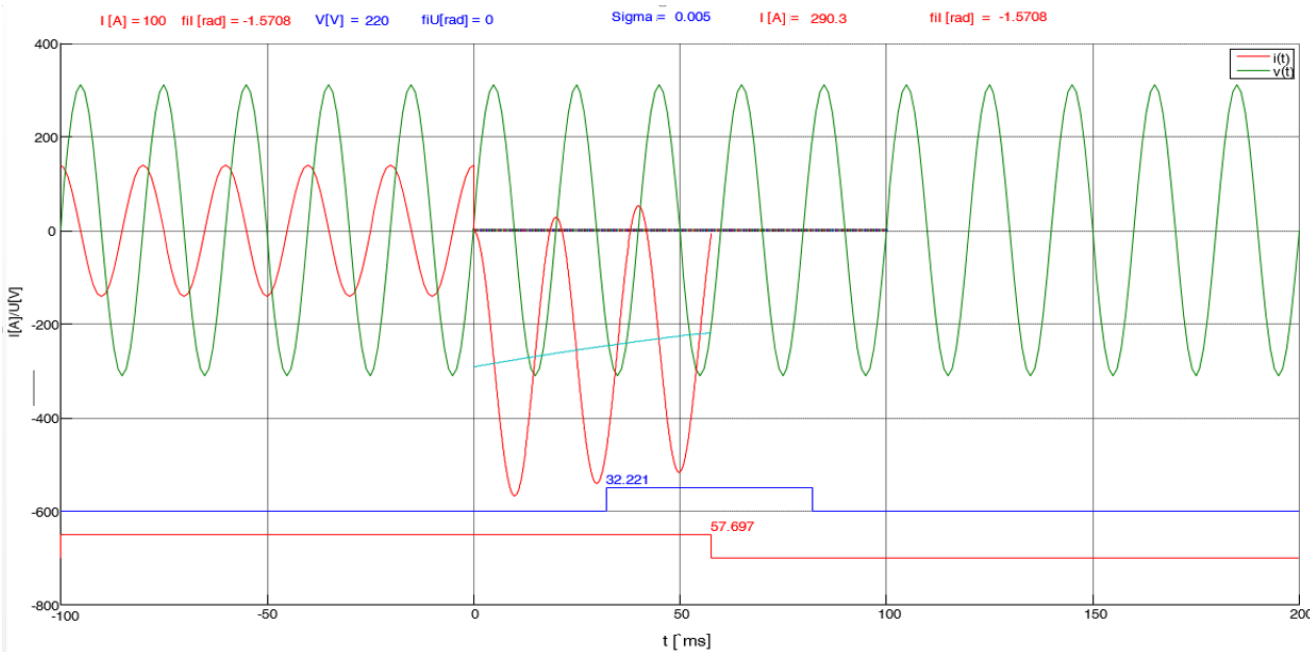
Figure 18. Transient switching diagram for capacitive load, ɸ Idef = π /2, Idef = 290.3 A, σ = 0.005, t command = 32.221 ms, t disconnect = 57.697 ms.